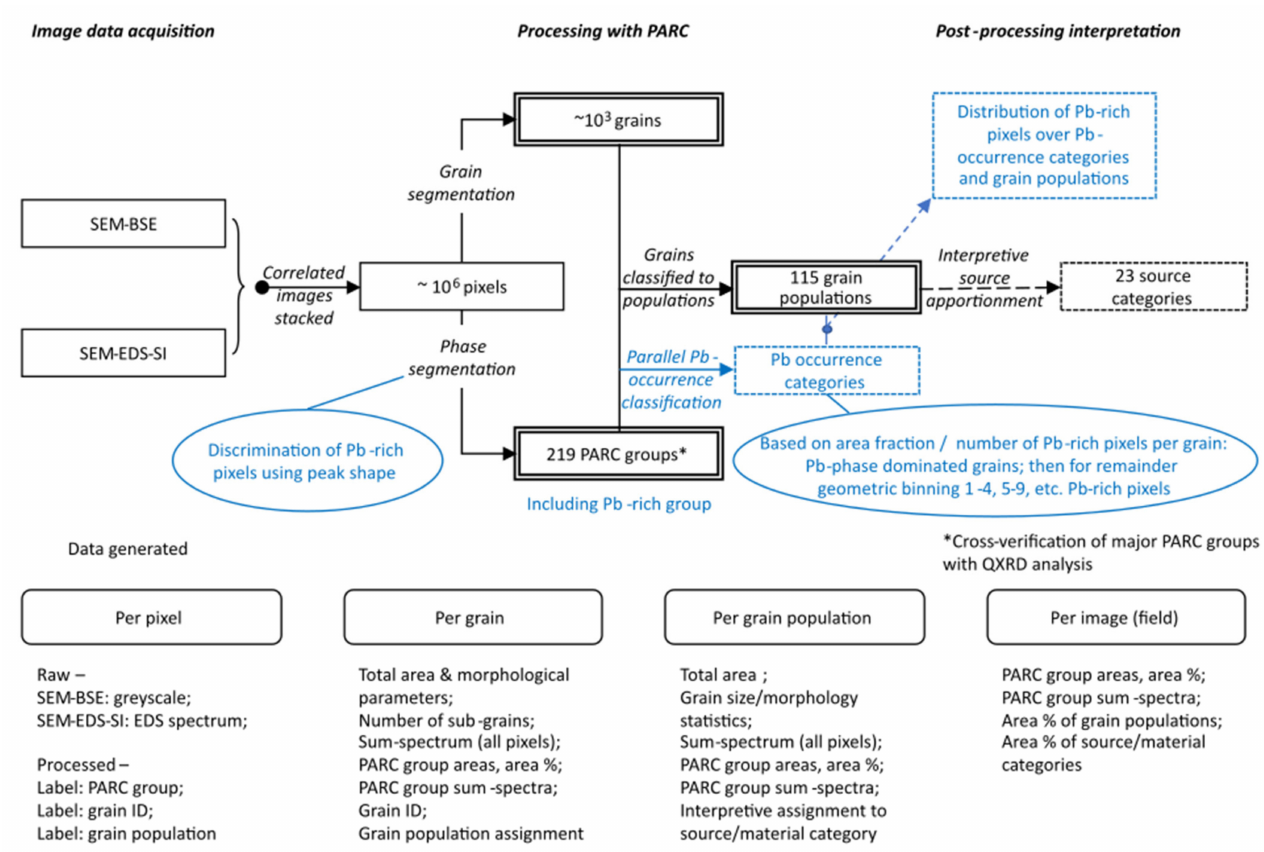
Figure 2. Flowchart of raw (spectral-)image data acquired, processing and data generated by PARC software (PhAse Recognition and Characterisation, [14]), adapted to the current study from [13]. Processing steps indicated with arrows and italic text. Key to outlines in flow-chart: single solid line = image/image stack; double solid line = segmented image (map); single dashed line = derived information. Data produced per PARC group are listed under the relevant grain/grain population/field mask used to collate pixels. The number of PARC groups, grain populations and interpretive source categories in the processing is indicated. Number of pixels and grains varies per dataset and the numbers shown are approximate indications only. Additions in the current study, regarding Pb detection are marked in blue. SEM = scanning electron microscopy; EDS = energy dispersive spectroscopy; BSE = backscattered electron (imagery); SI = spectral imaging; QXRD = quantitative X-ray diffraction; ID =